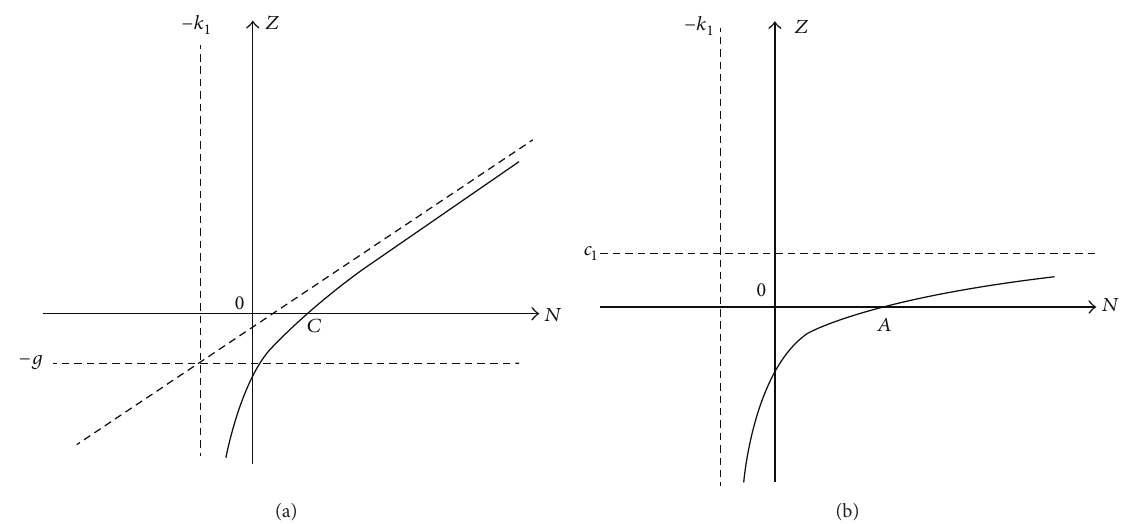
Figure 1: Figures of (8) and (9), where (a) is the figure of (9) and (b) is the figure of